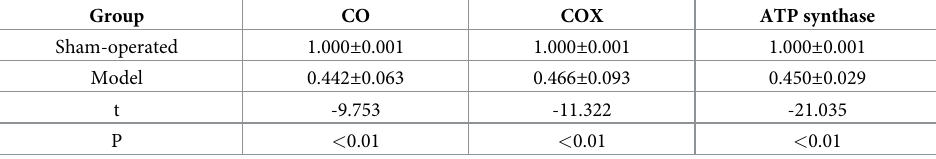
Table 3. Expression of mitochondrial structural protein mRNA in macrophages of two groups of